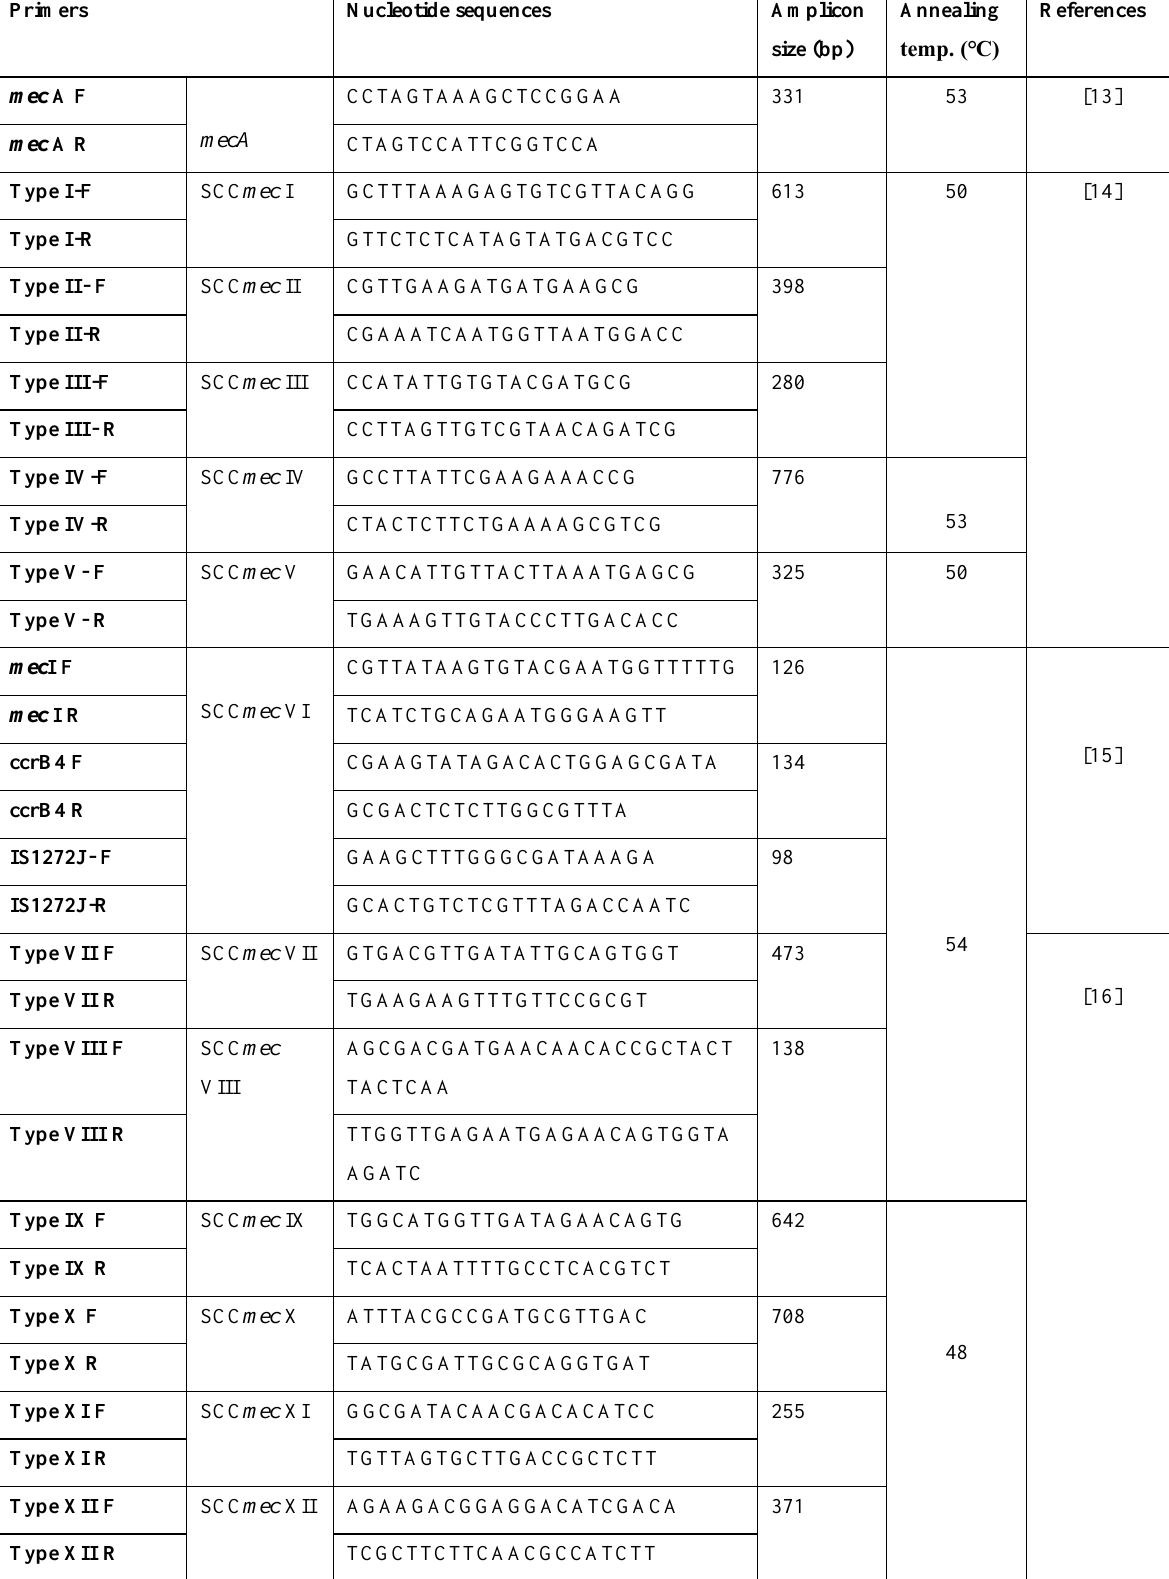
Table 1. Sequence of primers used in this